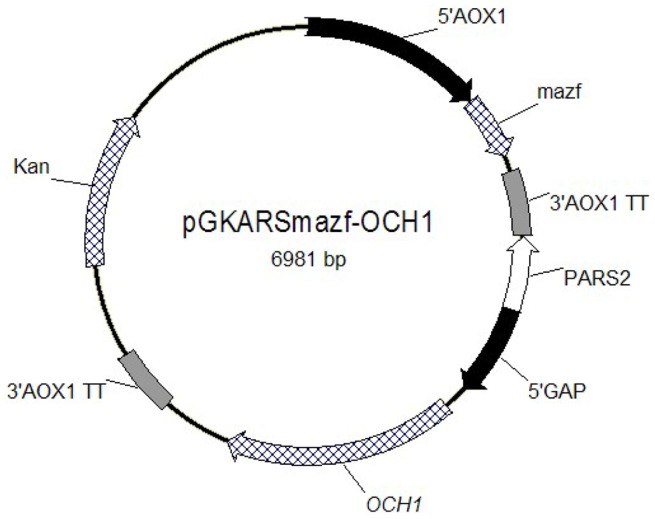
Schematic representation of the helper plasmid.pGKARSmazf-OCH1, the helper plasmid for OCH1 gene deletion, was used as an illustrative example. This plasmid consists of three key elements, the Pichia pastoris autonomous replication sequence (PARS2) fragment (allows plasmid maintenance within the cells), the strong constitutive glyceraldehyde-3-phosphate dehydrogenase (GAP) promoter, and the mazf expression cassette (facilitates plasmid removal when necessary).